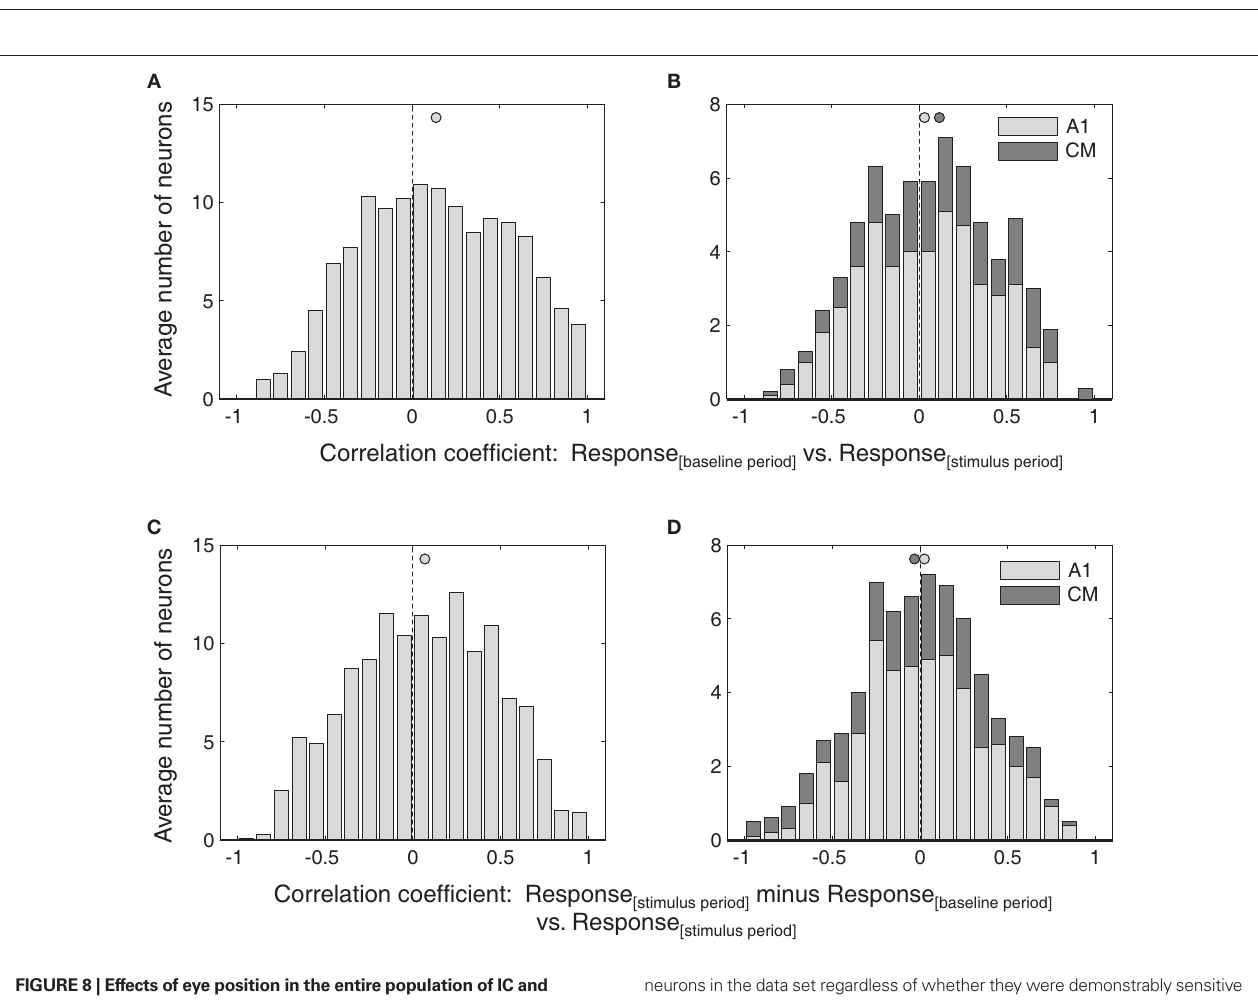
FIgure 8 | effects of eye position in the entire population of IC and auditory cortical neurons. The correlation of baseline versus stimulus period (A,B) and stimulus minus baseline versus stimulus periods (C,d) for all the